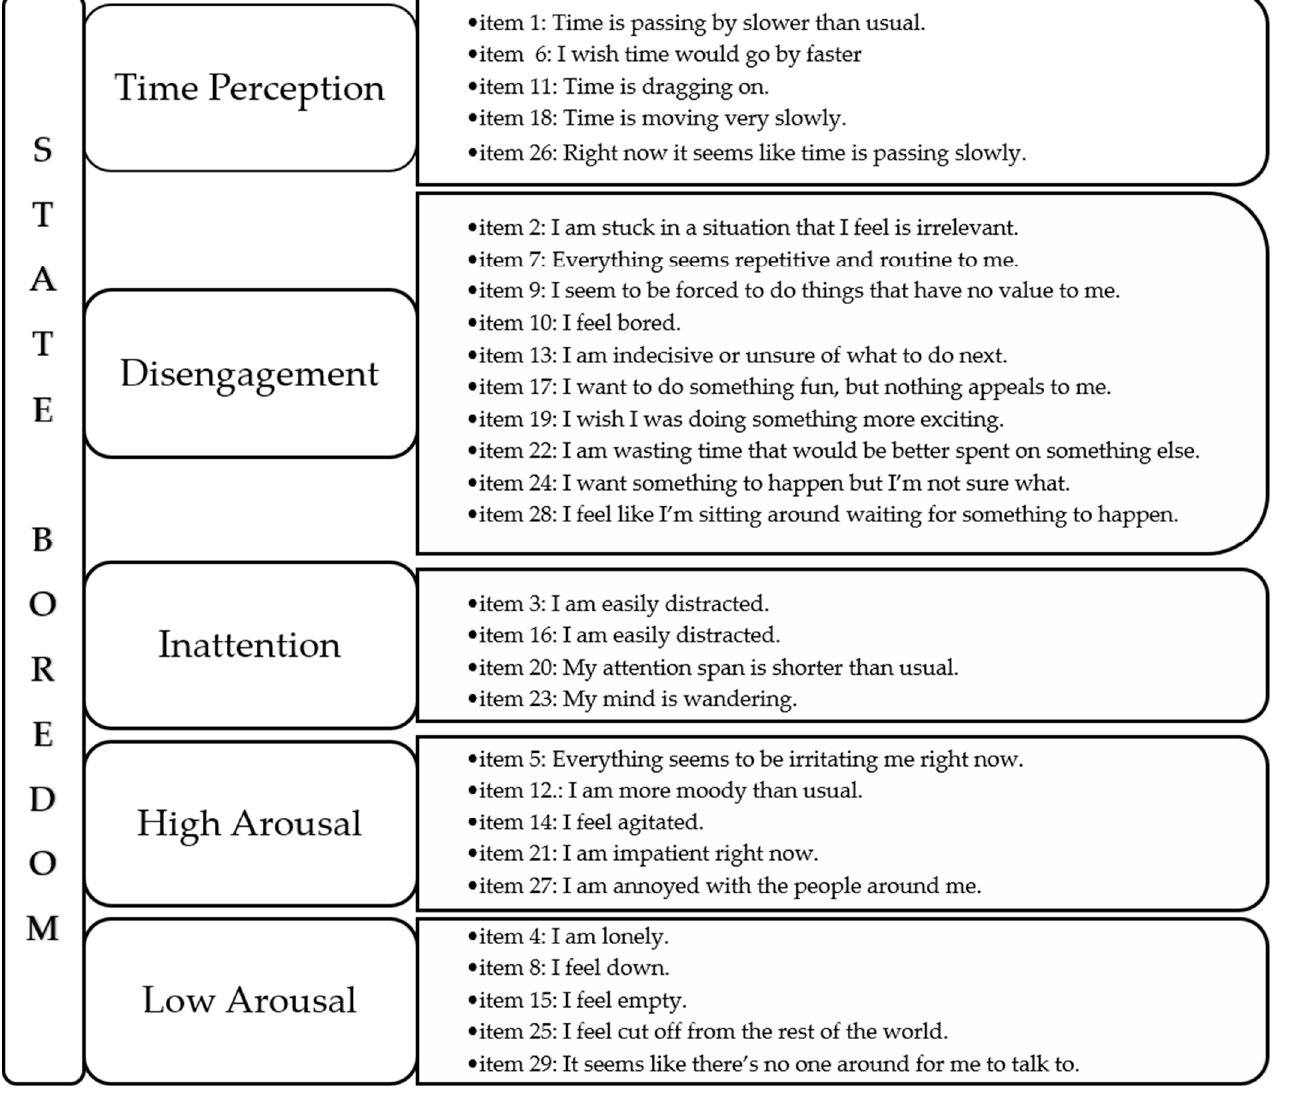
Figure 1. Factor structure and item grouping in the original version of the Multidimensional State Boredom Scale (MSBS). Notes: TP, time perception; DIS, disengagement; INA, inattention; HA, high arousal; LA, low arousal.